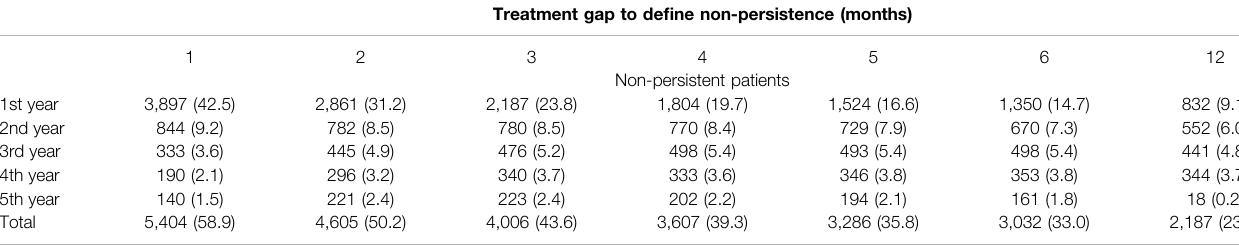
TABLE 3 | Sensitivity analysis of the effect of different lengths of treatment gap period de fi ning non-persistence. Treatment gap to de fi ne non-persistence